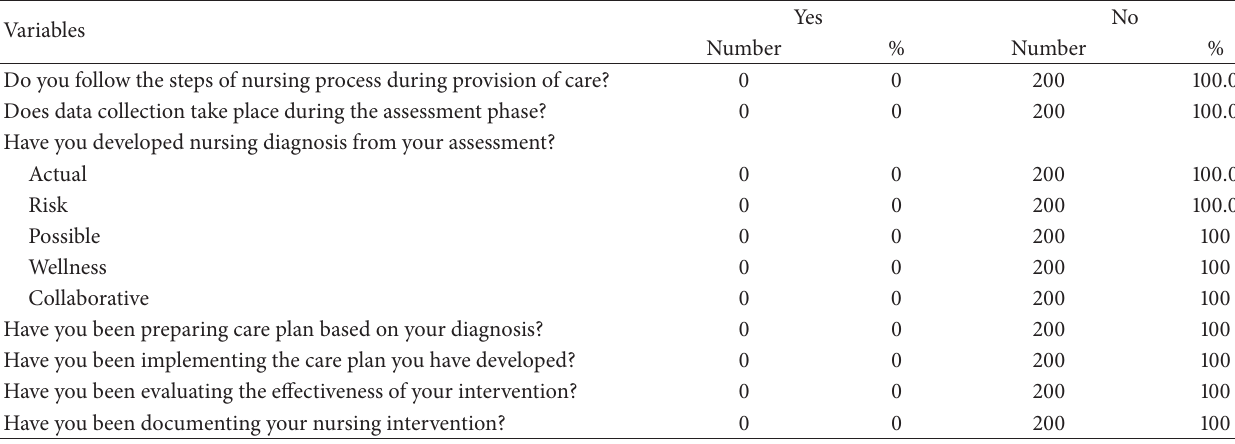
Table 3: Description the application of nursing process by the nurses of Mekelle Zone Hospitals, northern Ethiopia, March 2011 ( 𝑛 = 200 ). Variables Do you follow the steps of nursing process during provision of care? 0 0 200 100.0